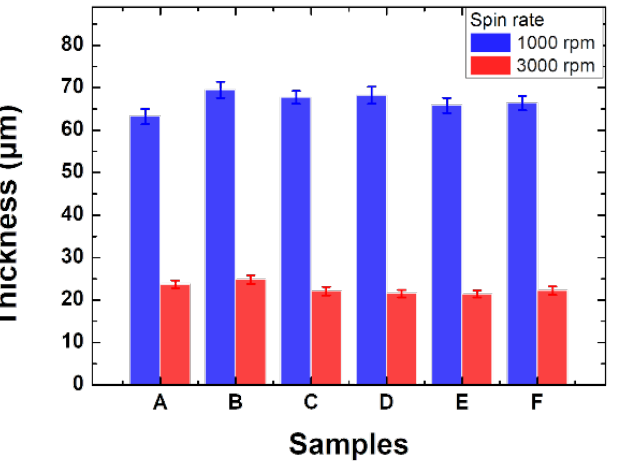
Figure 3. The thickness of the thin film formed according to the spin coating speed of 1000 rpm (solid blue), and 3000 rpm (solid red), respectively.